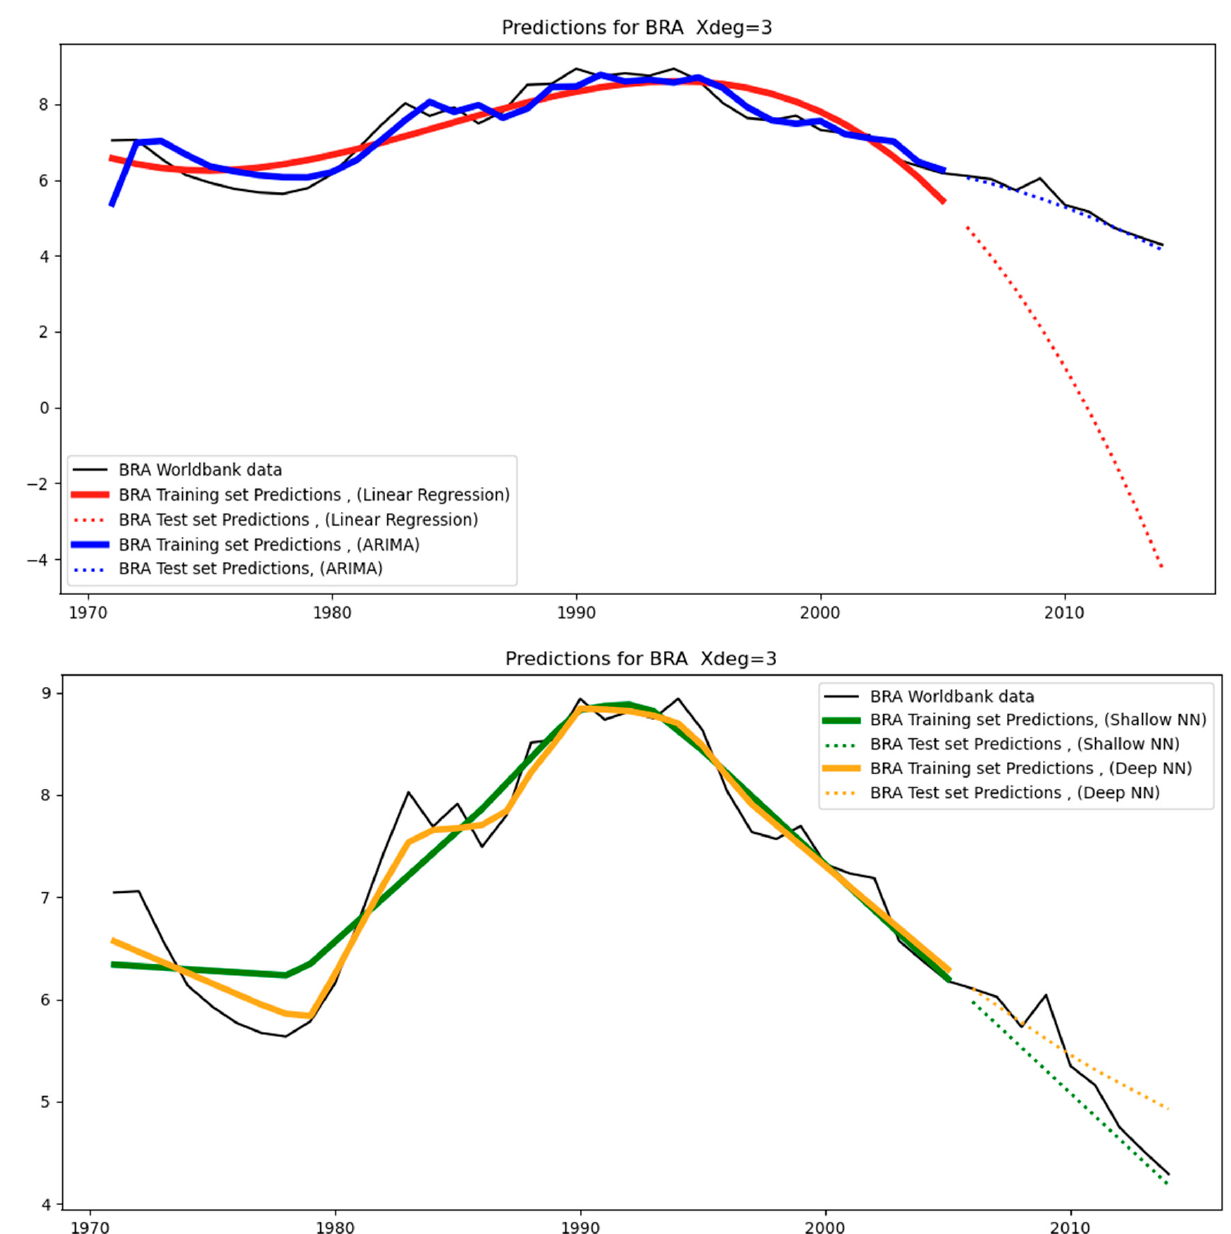
Figure 10. Predictions for Brazil (BRA), with a third-degree polynomial (Xdeg = 3), are shown for both the training set (periods 1971–2005) and the test set (periods 2006–2014), using linear regression (LR), ARIMA, shallow neural networks, and deep neural network models.